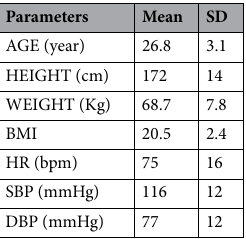
Table 1. Demographic characteristics of the population in study. Data are expressed as mean ± standard deviation (SD). BMI, body mass index; HR, heart rate; SBP, systolic blood pressure; DBP, diastolic blood